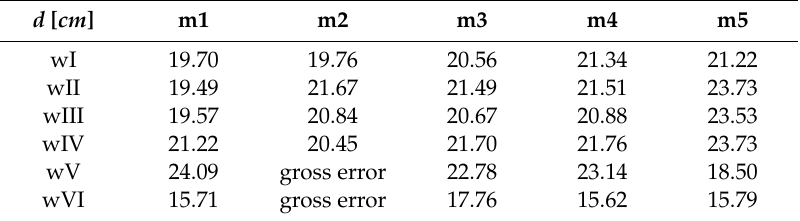
Table 8. Calculated slabs thicknesses based on the wave amplitude reflected from the surface.